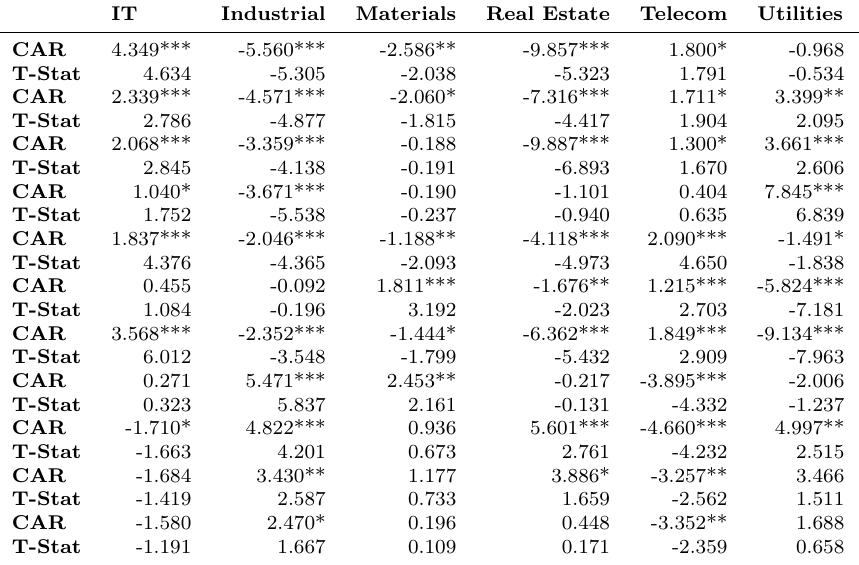
Table 6: Event 3 19-03-2020 First Order of ”Stay at Home” IT Industrial Materials Real Estate Telecom Utilities